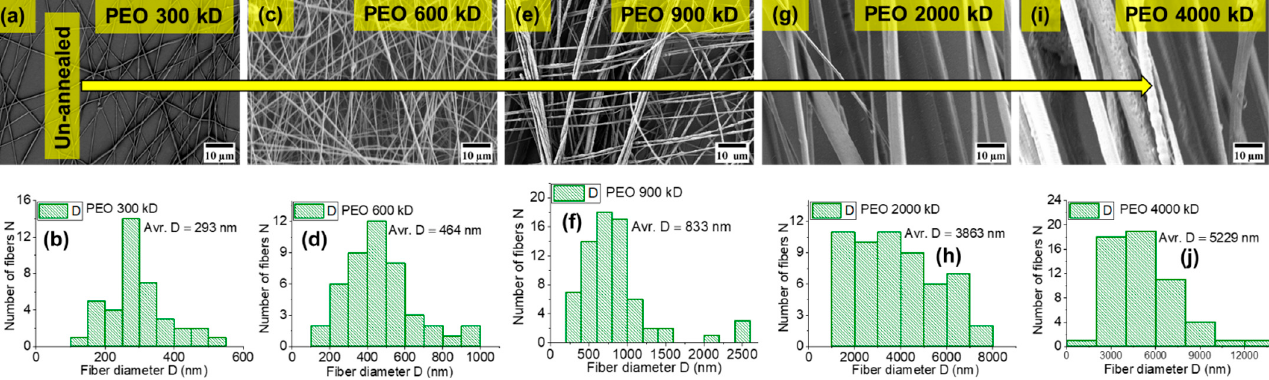
Figure 3. The Panels ( a – j ) represent the SEM analysis for PEO-300 kD, PEO-600 kD, PEO-900 kD, PEO-2000 kD, and PEO-4000 kD fibers with their fiber-diameter histograms, respectively. The concentration of PEO matrix is fixed up to 2% ( φ PEO ≈ 2%) in spinning solutions for all molar masses (300–4000 kD). Note: A small misalignment of fibers is an issue when handling fibers during preparation of samples for SEM measurements.